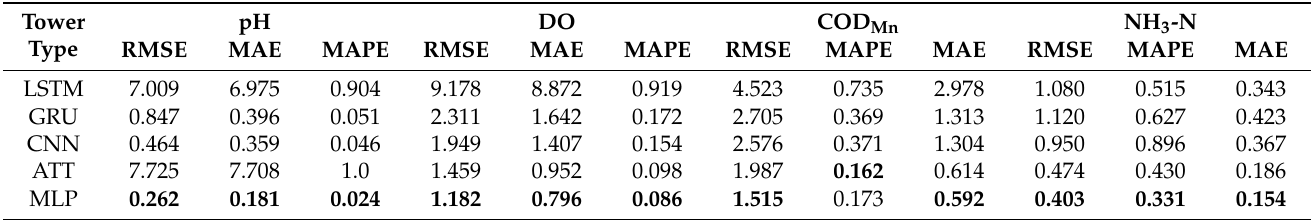
Table 7. The performance comparison of tower structures in the Multi-Task-GH model.